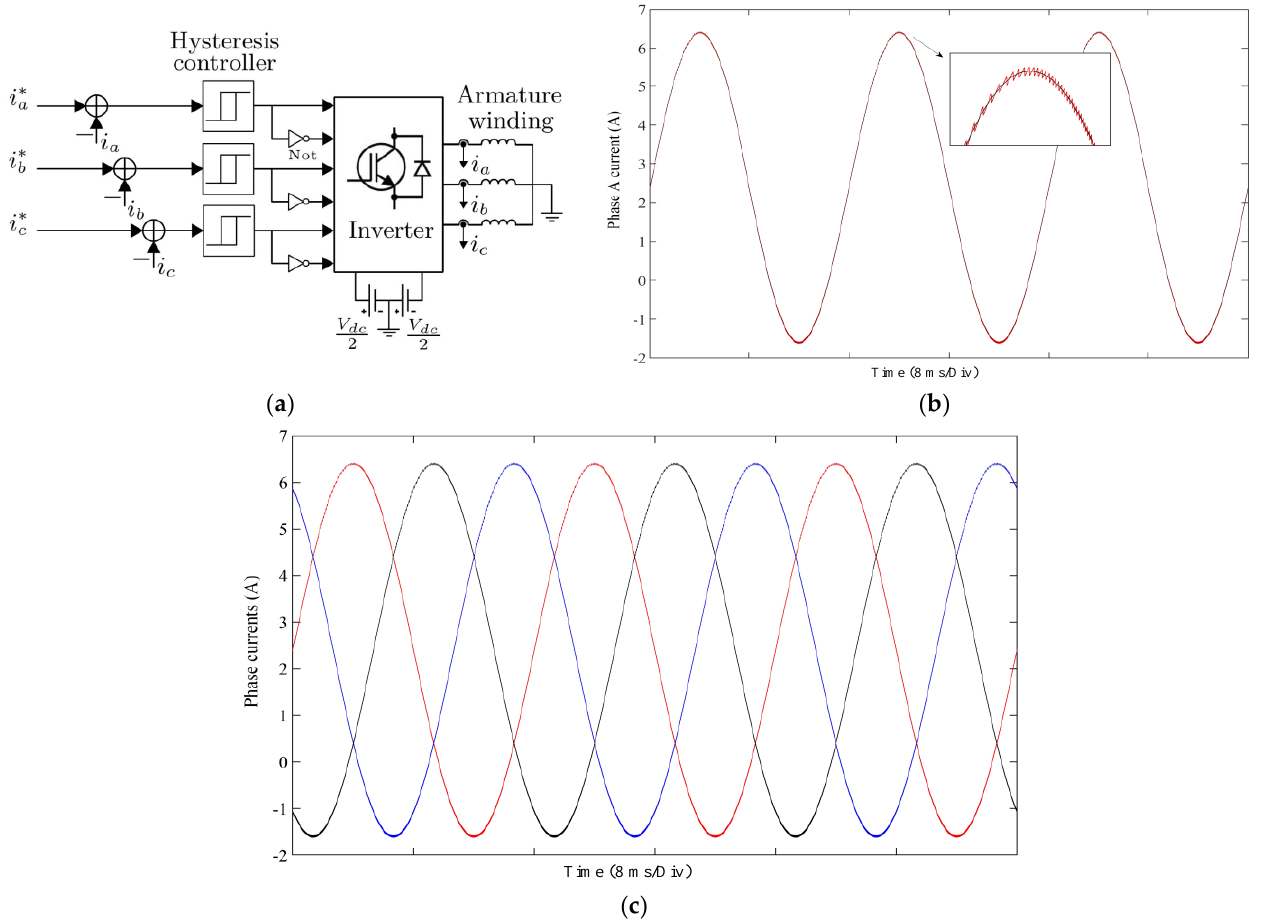
Figure 3. ( a ) Proposed inverter topology, ( b ) reference and controlled output current for phase A, and ( c ) controlled three-phase output currents of the inverter.